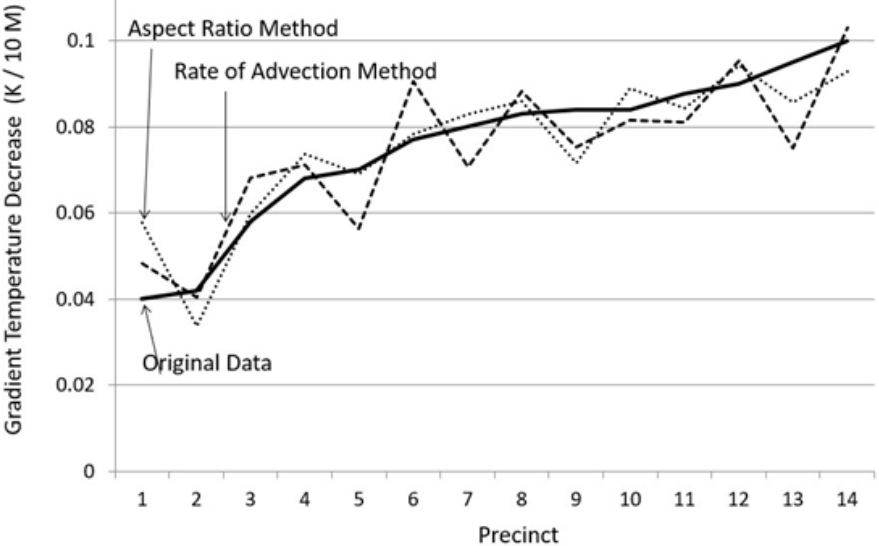
Figure 14. Prediction of the GTD mitigation for the mitigated scenarios with the two proposed methods. The advection rate in the precincts is highly dependent on the canyon orientation and aspect ratio. The wind speed in canyons with an axis vertical or oblique to the wind direction presents a lower wind speed is lower compared to wind speed in canyons with a parallel axis to the wind direction. This depends highly on the aspect ratio, ( H/W ), of the canyons, as derived by Oke [45]. For canyons vertical or oblique to the wind direction, a high H/W value > 0.8 signifies that the flow is under a skimming regime and corresponds to a local vortex inside the canyon, and a bypass of the flowing air above the height of the buildings. For H/W values between 0.8 and 0.3, the flow is the wake interface, and for lower values is isolated roughness